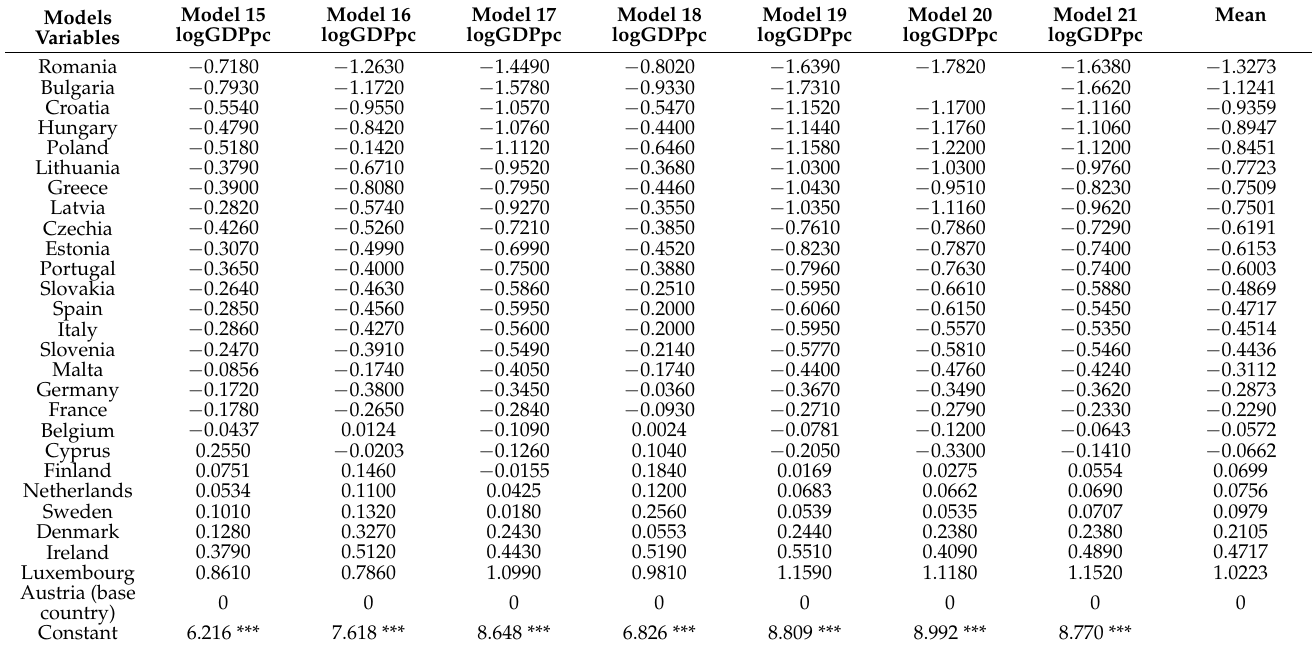
Table 7. Means of country coefficients of Prais–Winsten models Regression models with breakdown of public expenditure on health by